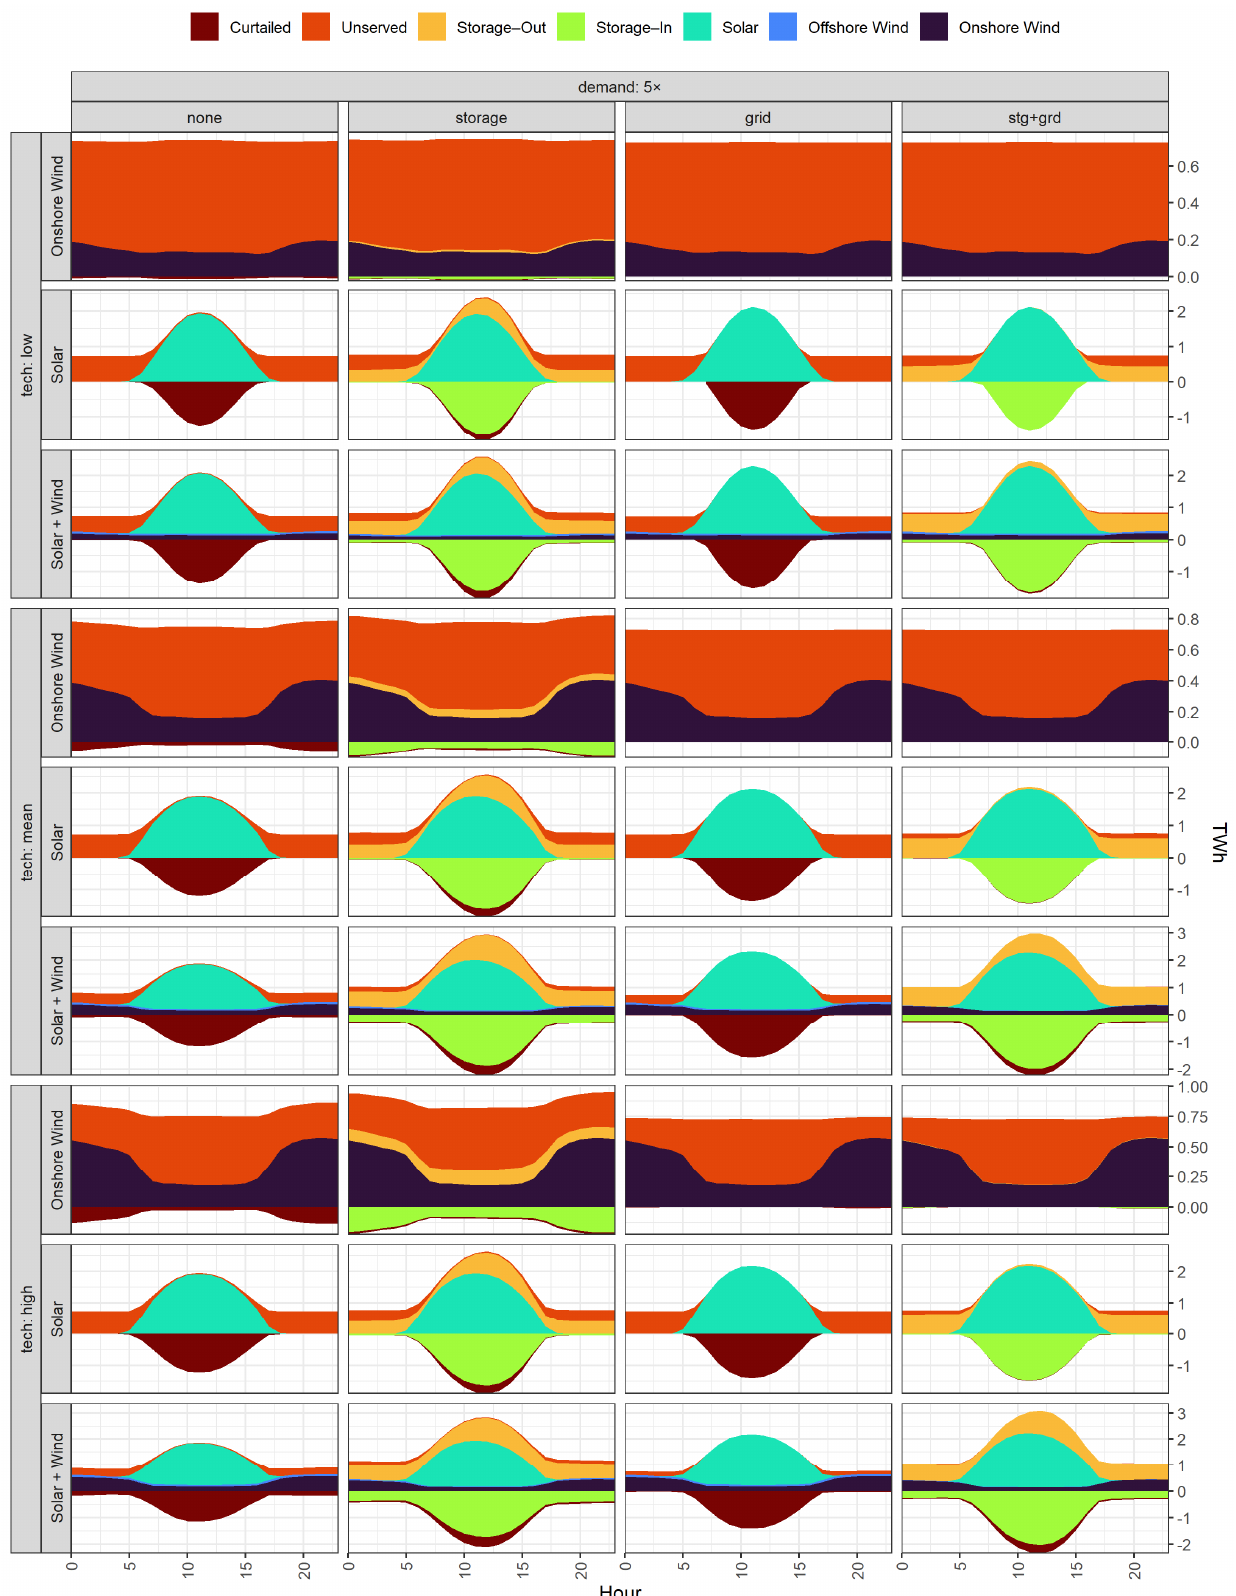
Figure A18. Annual average generation profile by hours and scenario (5× group).